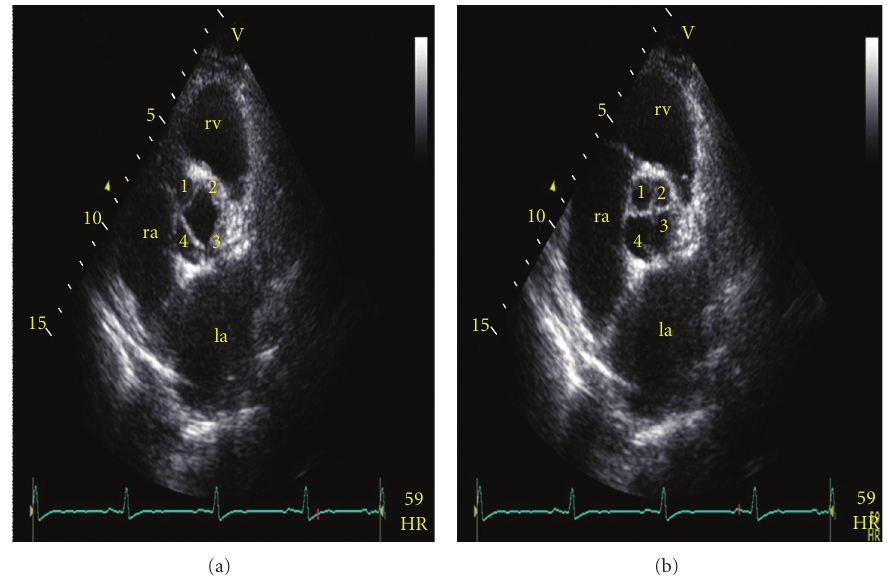
Figure 1: Transthoracic echocardiography images. Short axis view during systole (a) and diastole (b). ra: right atrium, la: left atrium, and rv: right ventricule.